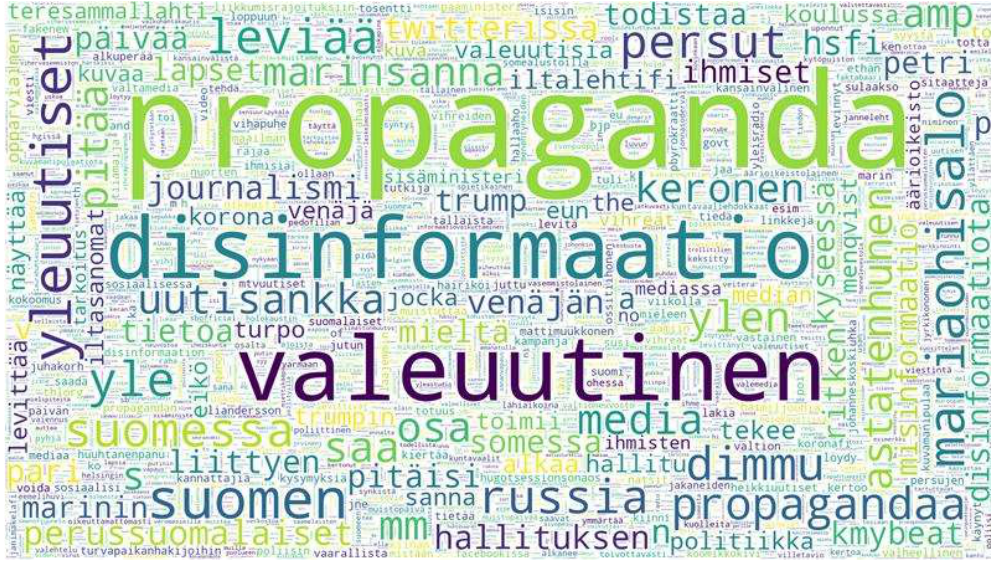
Figure 1. Word cloud of tweets.